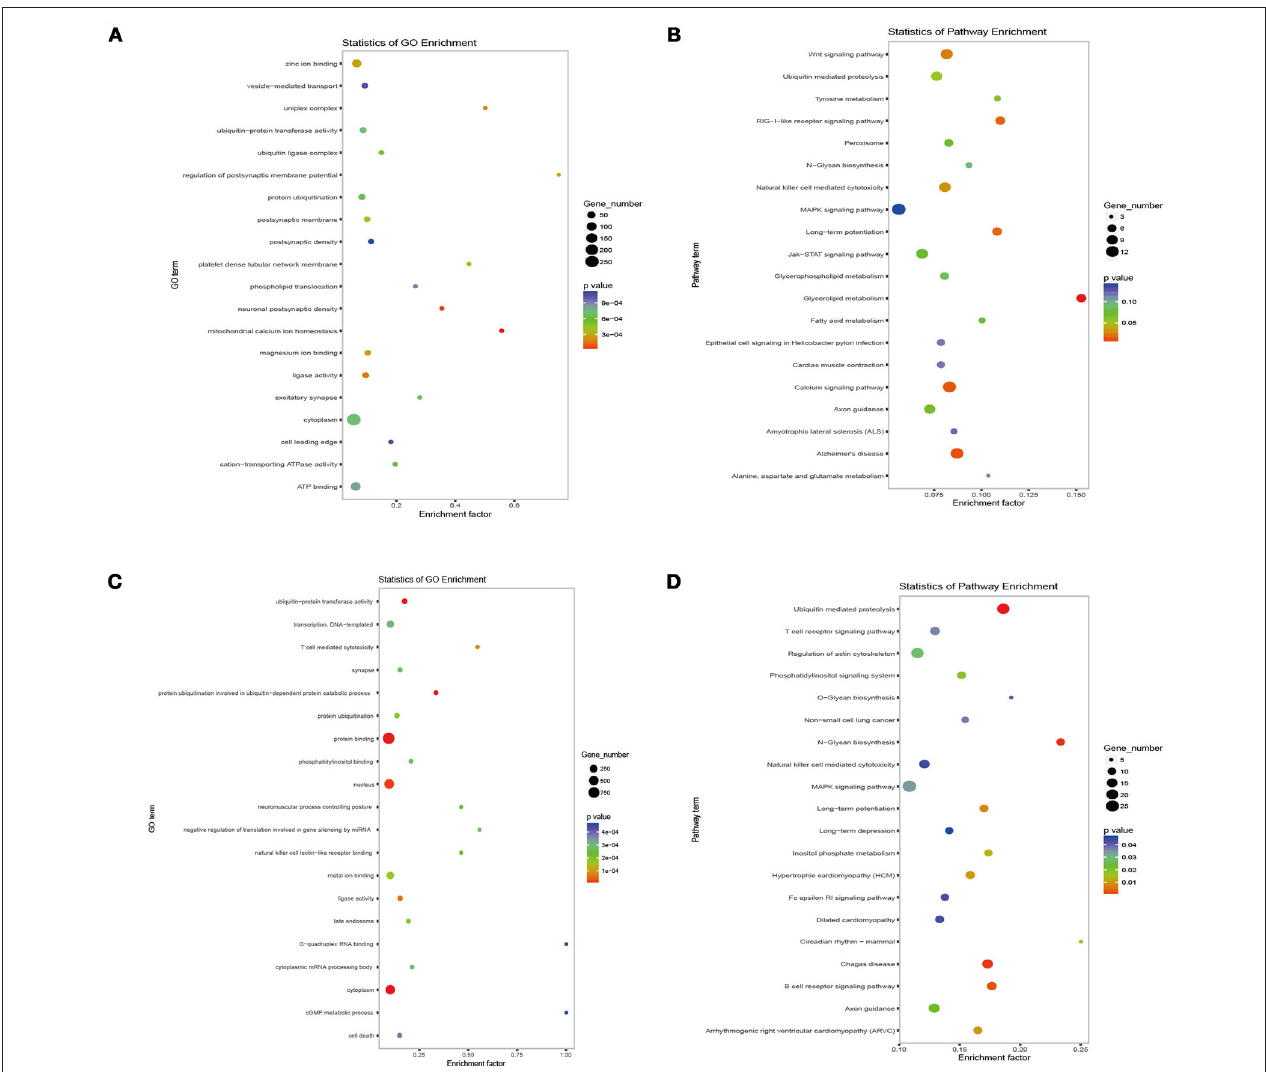
FIGURE 4 | Target analysis of miRNAs altered by high-altitude hypoxia. The biological function prediction of miR-144-5p was performed by GO (A) and KEGG analysis (B) . The potential targets of miR-30b-5p by GO and KEGG analysis are shown in (C,D) .